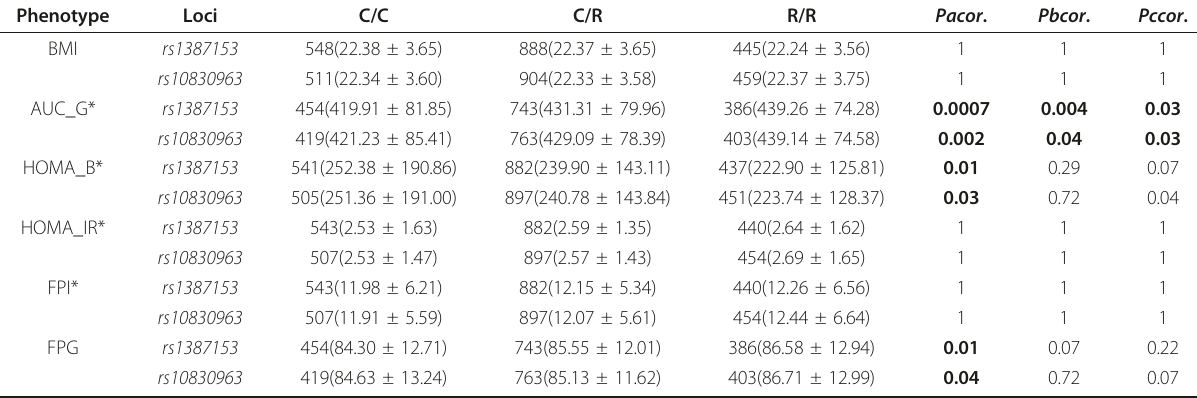
Table 5 Multiple regression analyses of MTNR1B polymorphisms with diabetes-related phenotypes among all